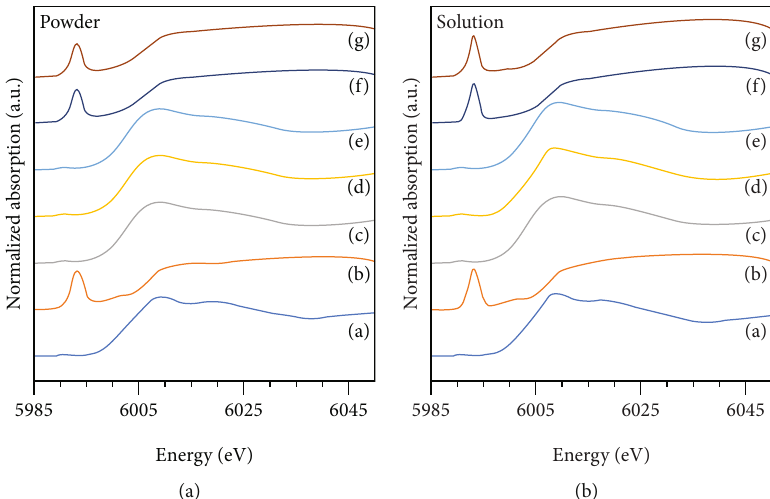
Figure 4: Preedge feature of normalized Cr K-edge XANES spectra of references and samples included the (a) Cr(III) reference, (b) Cr(VI) reference, (c) NTB+Cr(III), (d) 1HDTMA+Cr(III), (e) 1CPC+Cr(III), (f) 1HDTMA+Cr(VI), and (g) 1CPC+Cr(VI).